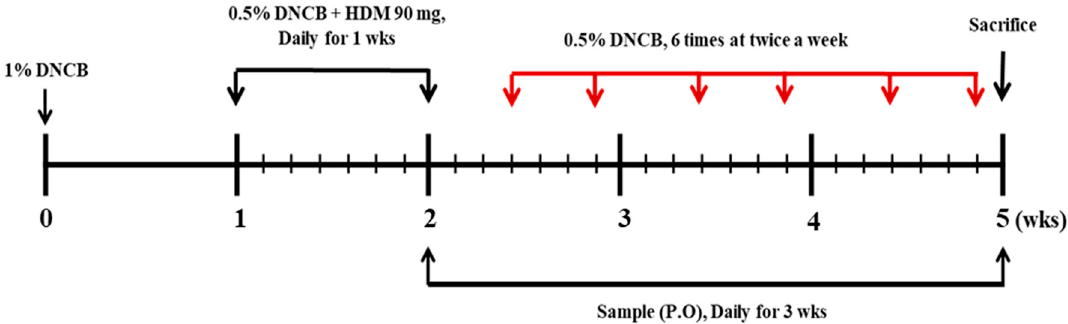
Figure1. SuppressionofHDM / DNCB-inducedADbyoraladministrationofSHE(10, 50, and100mg / kg). Figure 1. Suppression of HDM/DNCB-induced AD by oral administration of SHE (10, 50, and 100 Schematic illustration of 6-week experimental mg/kg). Schematic illustration of 6-week experimental design.